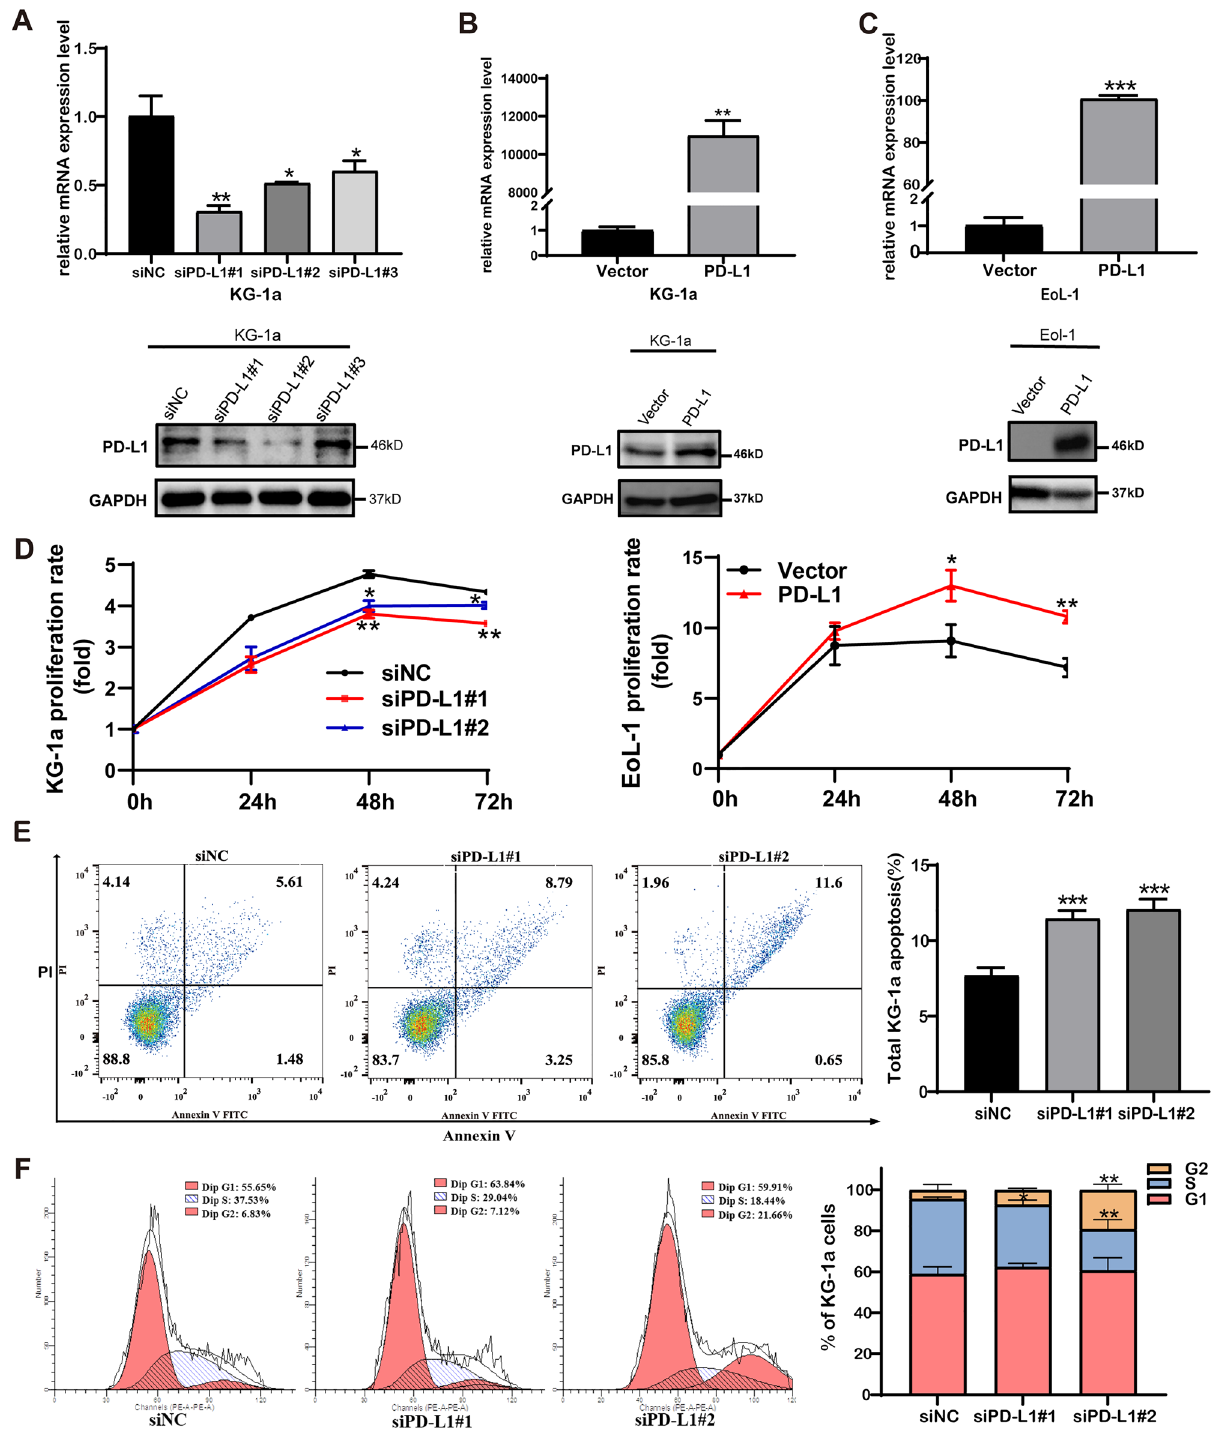
Figure 5. Effect of PD-L1 manipulation on cell proliferation, apoptosis and cell cycle in AML cell lines. ( A ) Validation of PD-L1 knockdown in KG-1a cells by RT-qPCR and western blot. The PD-L1 protein expression was decreased in siPD-L1#1 and siPD-L1#2 groups compared with siNC group. ( B ) Validation of PD-L1 overexpression in KG-1a cells by RT-qPCR and western blot. PD-L1 protein expression was significantly increased in overexpressing group. ( C ) Validation of PD-L1 overexpression in EoL-1 cells by RT-qPCR and western blot. PD-L1 protein expression was significantly increased in overexpressing group. ( D ) Knockdown of PD-L1 expression suppresses the proliferation of KG-1a. At 48 and 72 h after seeding, the proliferation rate of siPD-L1 groups was significantly lower than that of siNC group. Up-regulation of PD-L1 expression promoted the proliferation of EoL-1. At 48 and 72 h after seeding, the proliferation rate of OE-PD-L1 group was significantly higher than that of the vector group. ( E ) Knockdown of PD-L1 expression promotes cell apoptosis in KG-1a cell lines. ( F ) Knockdown of PD-L1 expression could induce cell cycle arrest in G2/M phase in KG-1a cell line. The flow analysis showed that the percentage of cells in G2/M phase was 19.22% in siPD-L1#2 group and 4.35% in siNC cells, *P < 0.05, **P < 0.01, ***P < 0.001. Full-length blots are presented in Supplementary Figure S4 and